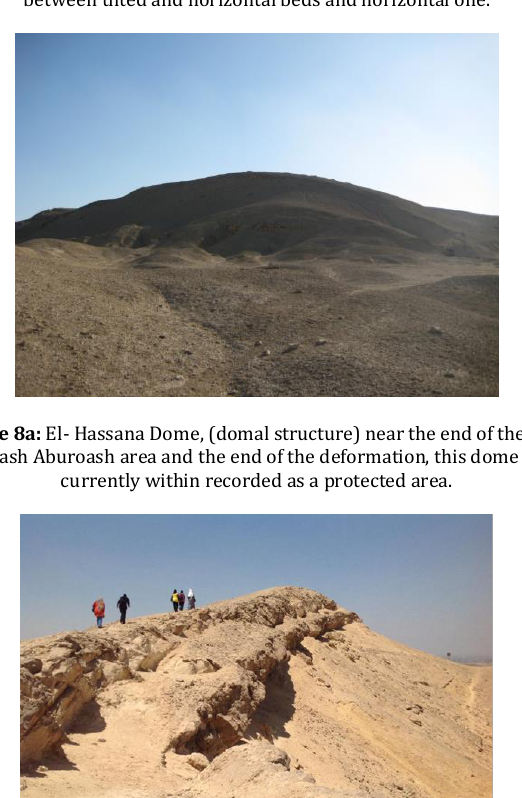
Figure 7: An angular unconformity is clearly shown clear unconformity between tilted and horizontal beds and horizontal one.